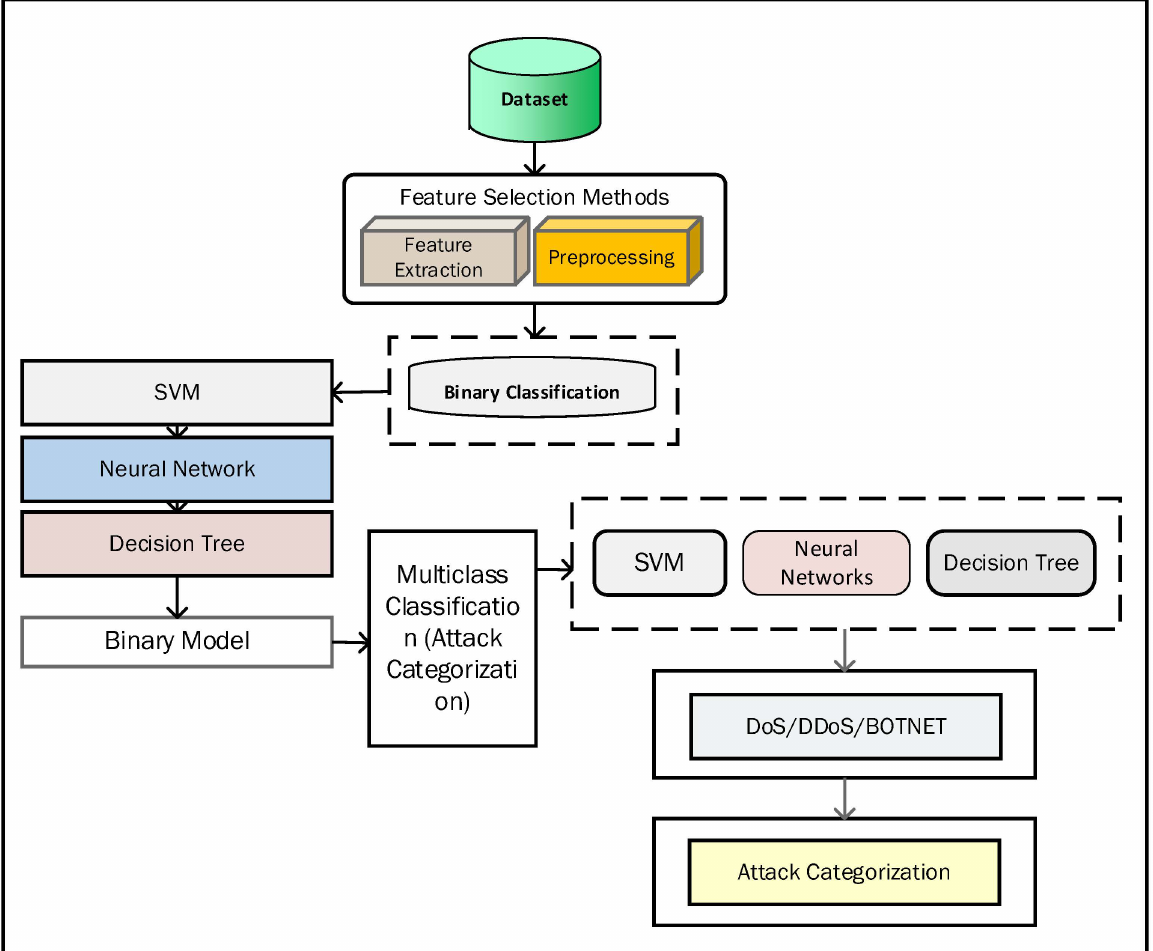
Figure 4. Training model